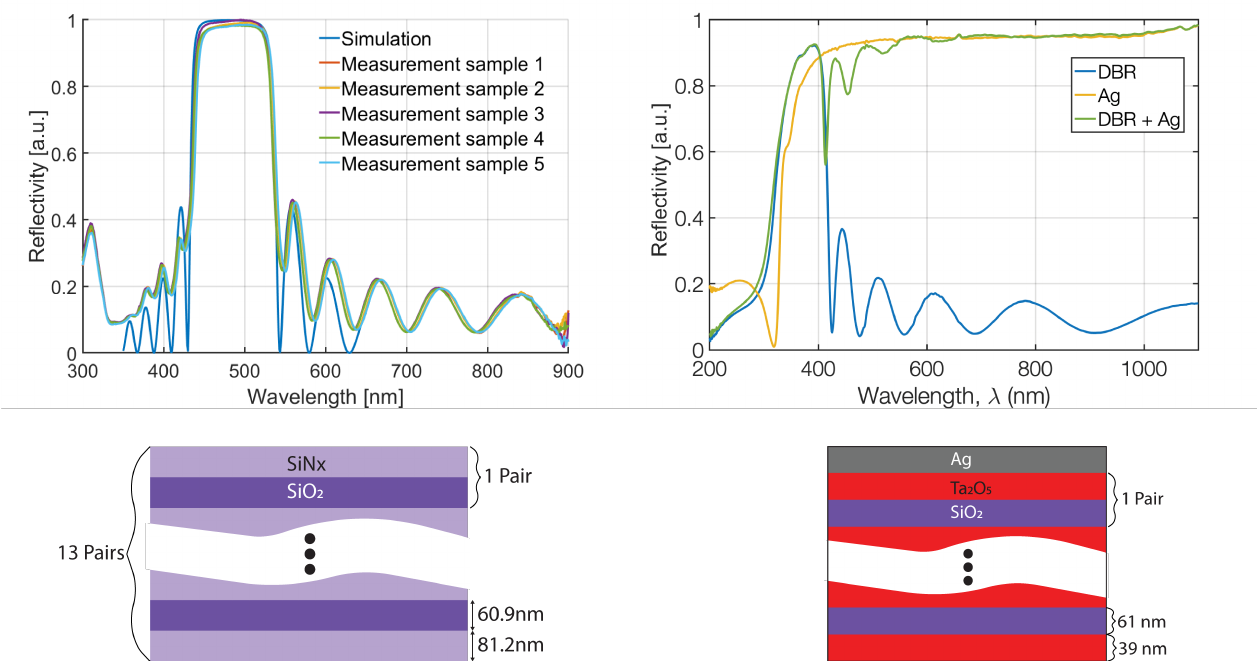
Figure 9. Reflectivity spectra of the DBRs implemented on glass substrates. Left : A conventional DBR designed with a center wavelength of 480 nm, to match the emission spectrum of BGO. Right : A combination of DBR (centered at 360 nm) and silver coating to extend the spectrum toward the red. Top row, left : Simulation results vs. measurements of different samples, Top row, right : Measurement results of the complete structure as well as its components. Bottom row: Schematic representation of the respective DBR